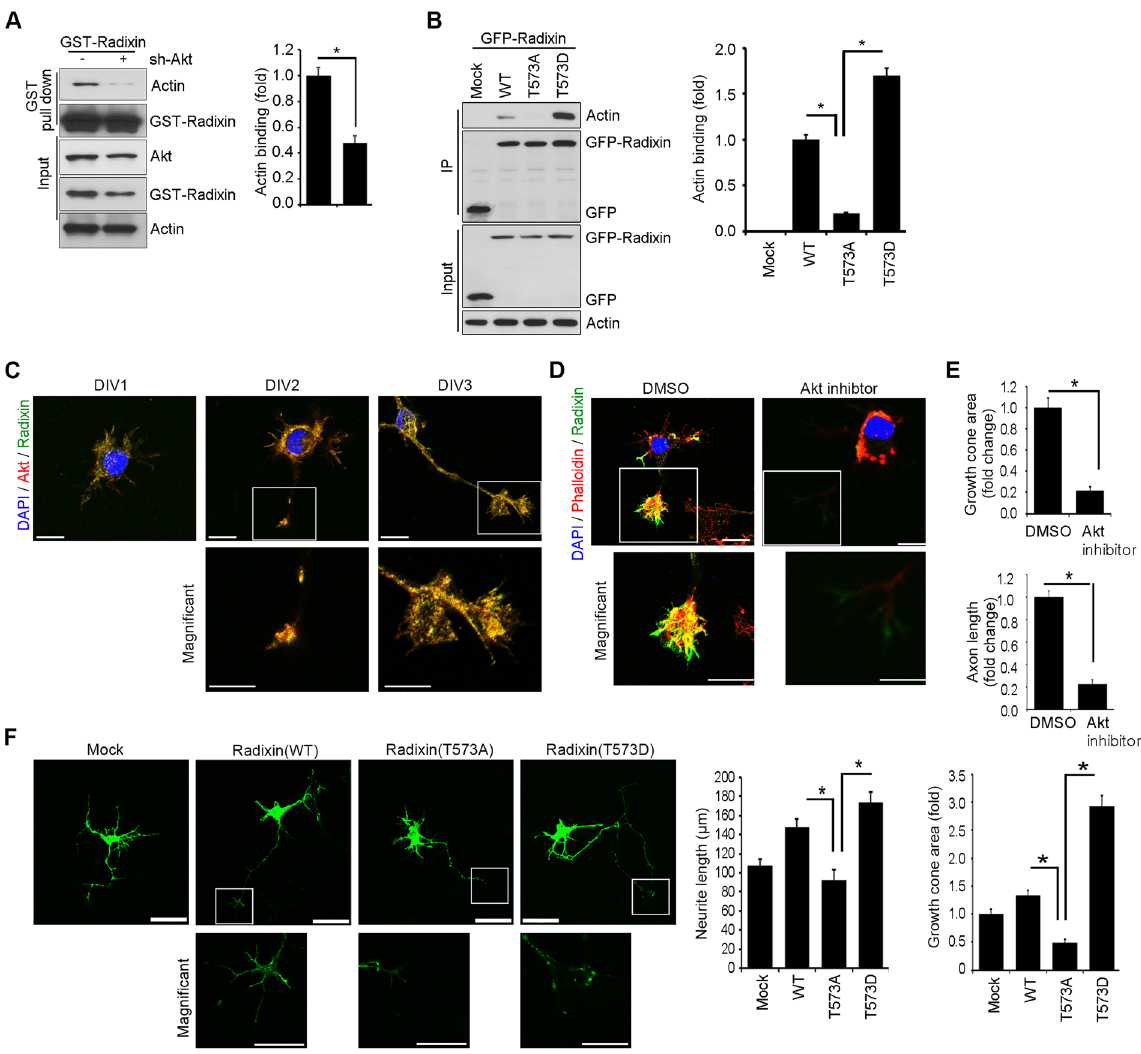
Figure 5. Disrupting Akt-mediated radixin phosphorylation impairs radixin function in growth cone. ( A ) PC12 cells were depleted of Akt by sh-Akt and were transfected with GST–radixin. Lysates were then subjected to GST pull-down assay. Immunoblotting was performed with the indicated antibodies ( B ) Hippocampal neurons (DIV 2) were transfected with GFP − radixin − WT, radixin–T573A, or radixin–573D, and cell lysates were subjected to immunoprecipitation with anti-GFP antibody. Protein-protein interactions are determined by IB using the indicated antibodies. ( A,B ) Actin binding affinity was analyzed by densitometry. * p < 0.05 versus indicated. Values are mean ± SEM from three independent experiments, and the image shown is representative of at least three independent experiments. ( C ) The representative merged image of localization of endogenous Akt (red) and radixin (green) in the developing hippocampus neurons (DIV 1–3). Enlargement of the boxed area is shown on the bottom. Scale bar, 50 μ m or 10 μ m. ( D ) Cultured hippocampal neurons were exposed to Akt inhibitor VIII and fixed at DIV 3. The neurons stained for radixin (green) and phalloidin (red). Quantification of growth cone size and axon length measurements from three independent experiments is shown ( D,E ). n = 16–24 cells. Error bars, SEM; Scale bar, 10 μ m or 50 μ m. * p < 0.05 versus indicated. ( F ) Cultured neurons were transfected with GFP fusion proteins of WT radixin, radixin–T573A, radixin–T573D, or GFP vector control at DIV 1 and fixed at DIV 3. The quantification of neurite length from three independent experiments is shown (bottom). ** p < 0.005 versus as indicated. Scale bar, 50 μ m or 10 μ